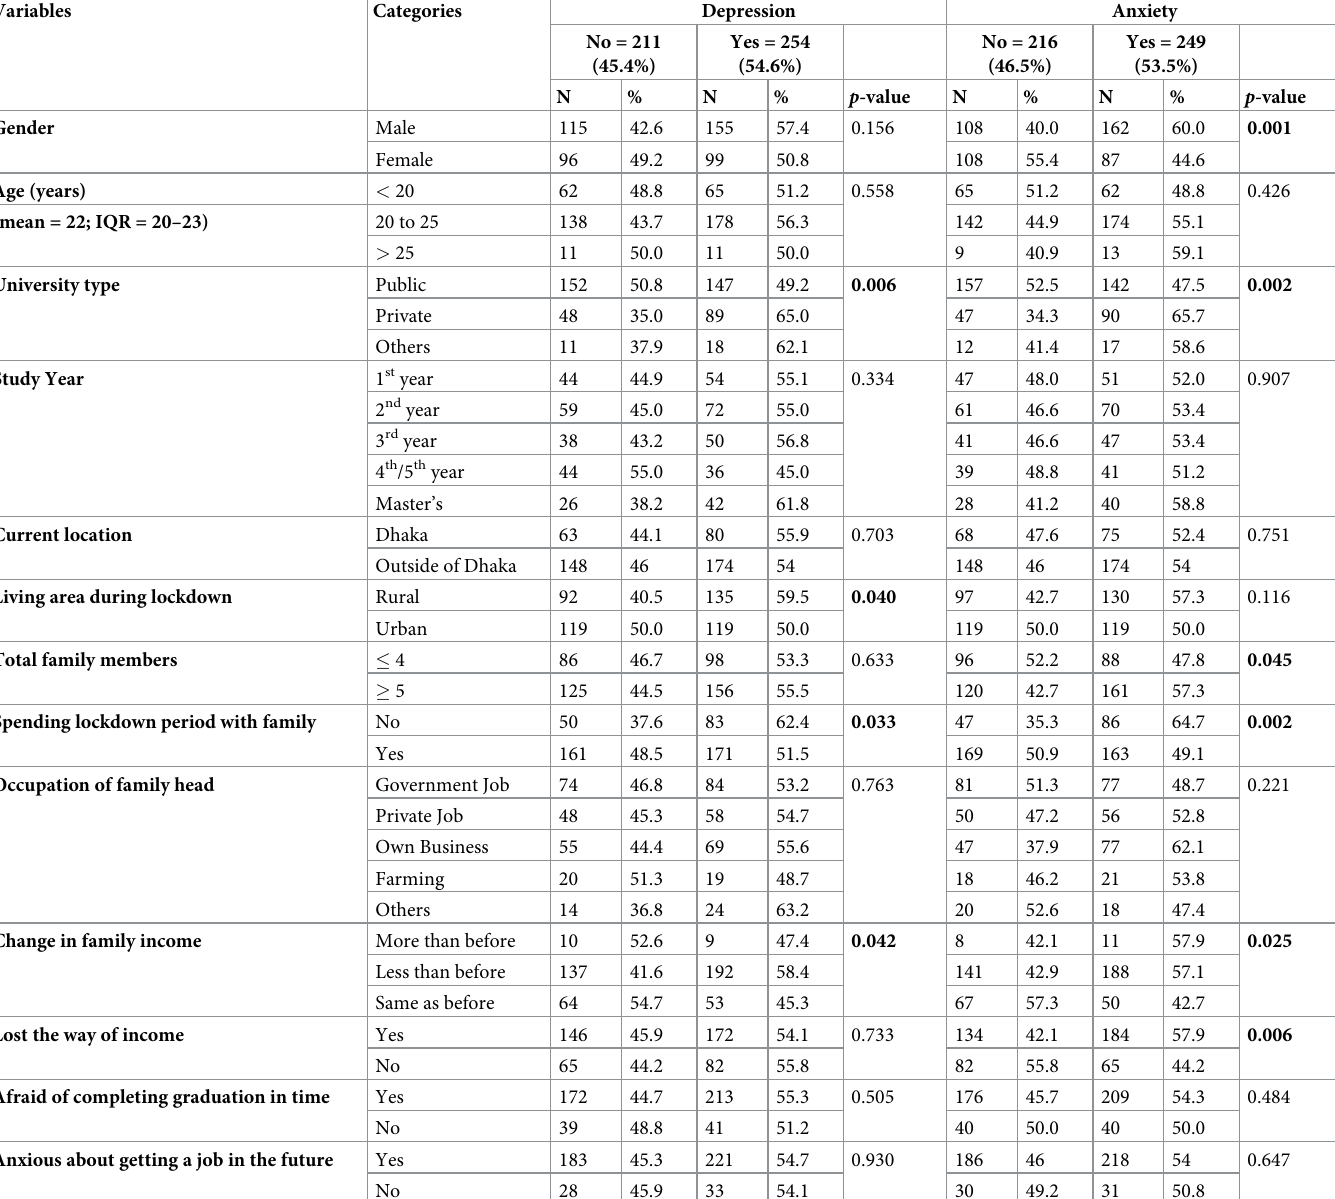
Table 2. χ 2 analysis for assessing the association of different sociodemographic factors with depression and anxiety among Bangladeshi university students during the COVID-19 lockdown. Variables Categories